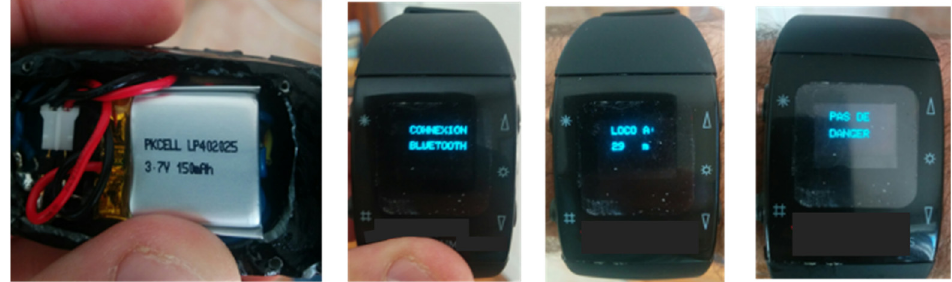
Figure 19. Watch connected in Bluetooth to the Hi-Rail pickup.